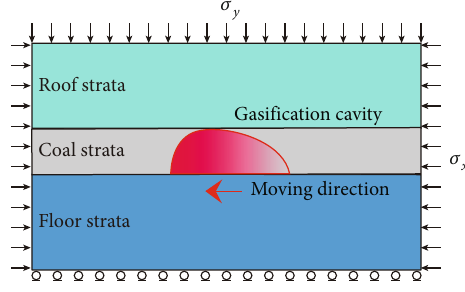
Figure 6: Numerical calculation